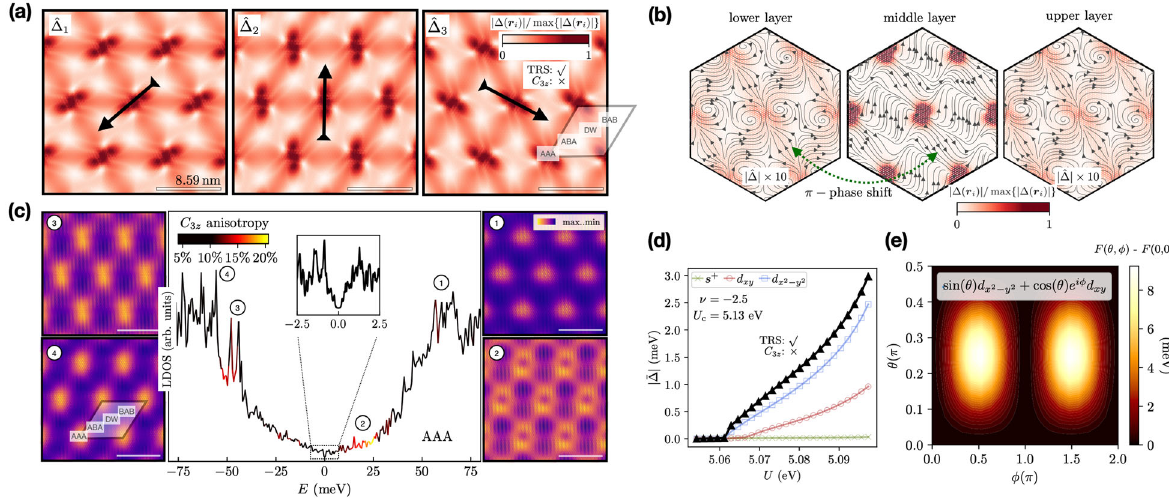
Fig. 2 Properties of the superconducting order parameter in MATTG for ν = − 2.5 and T = 0.2 K. a Spatially resolved atomistic gap j Δ ð r i Þj = max fj Δ ð r i Þjg in the outer layer of MATTG. Our analysis reveals three degenerate real-valued ground states that break C 3 z rotational symmetry on the moiré scale along the nematic axis C 2 (black arrow). b Layer-wise representation of the order parameter fi eld. The value of ∣ Δ ( r i ) ∣ is larger by a factor of ~10 in the middle layer compared to the outer layers with most weight being concentrated in the AAA regions. The phase of the superconducting gap is shifted by π between single layers. Additionally to the nematicity on the moiré scale, we fi nd strong local atomic-scale nematicity in the orientation of the d -wave components τ ( r i ) (black streamlines). The moiré nematicity is clearly visible due to the emergence of a vortex – antivortex pattern near the AAA regions. c Local density of states (LDOS) in the superconducting state ^ Δ 3 from a in the AAA region of the outer layer of MATTG. Peaks at selected energies (1) – (4), which correspond to fl at bands being gapped by the order parameter, show clear signatures of C 3 z symmetry breaking. In subpanel (2), the in fl uence of the C 2 nematic axis is visible: for low energies, quasiparticles are forbidden to occupy the AAA regions along the direction of C 2 due to the presence of the superconducting condensate but accumulate on both sides where the gap amplitude vanishes. This leads to a strong degree of C 3 z symmetry breaking as visualized by the color code in the main panel. d Strength of the superconducting order and its projections on the honeycomb d -wave components as a function of the Hubbard- U . The d -wave order parameter increases exponentially as a function of interaction strength U . The s + projection has negligible weight. e Free energy of all complex superpositions of the real-valued irreducible representations d xy and d x 2 (cid:2) y 2 . The minima in free energy occur for the real-valued nematic solutions (and their U (1) transformations)